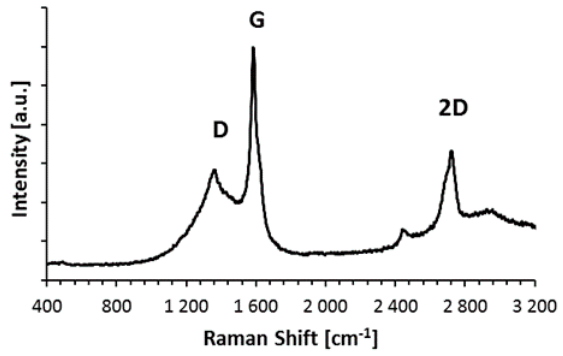
Figure 3. Raman spectra of Gn(12) MLG powder.